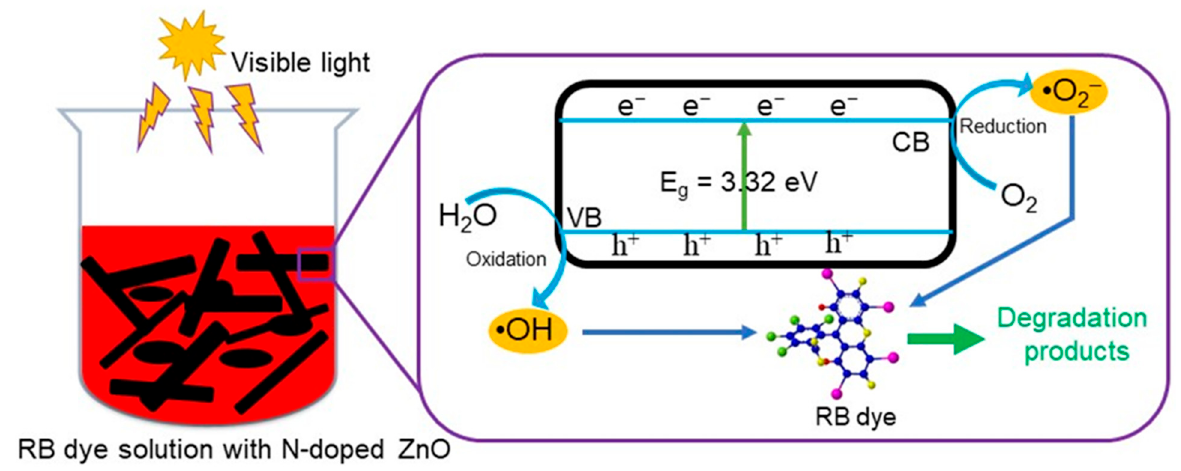
Figure 8. The proposed photocatalytic mechanism for the degradation of RB dye using N-doped ZnO catalyst.